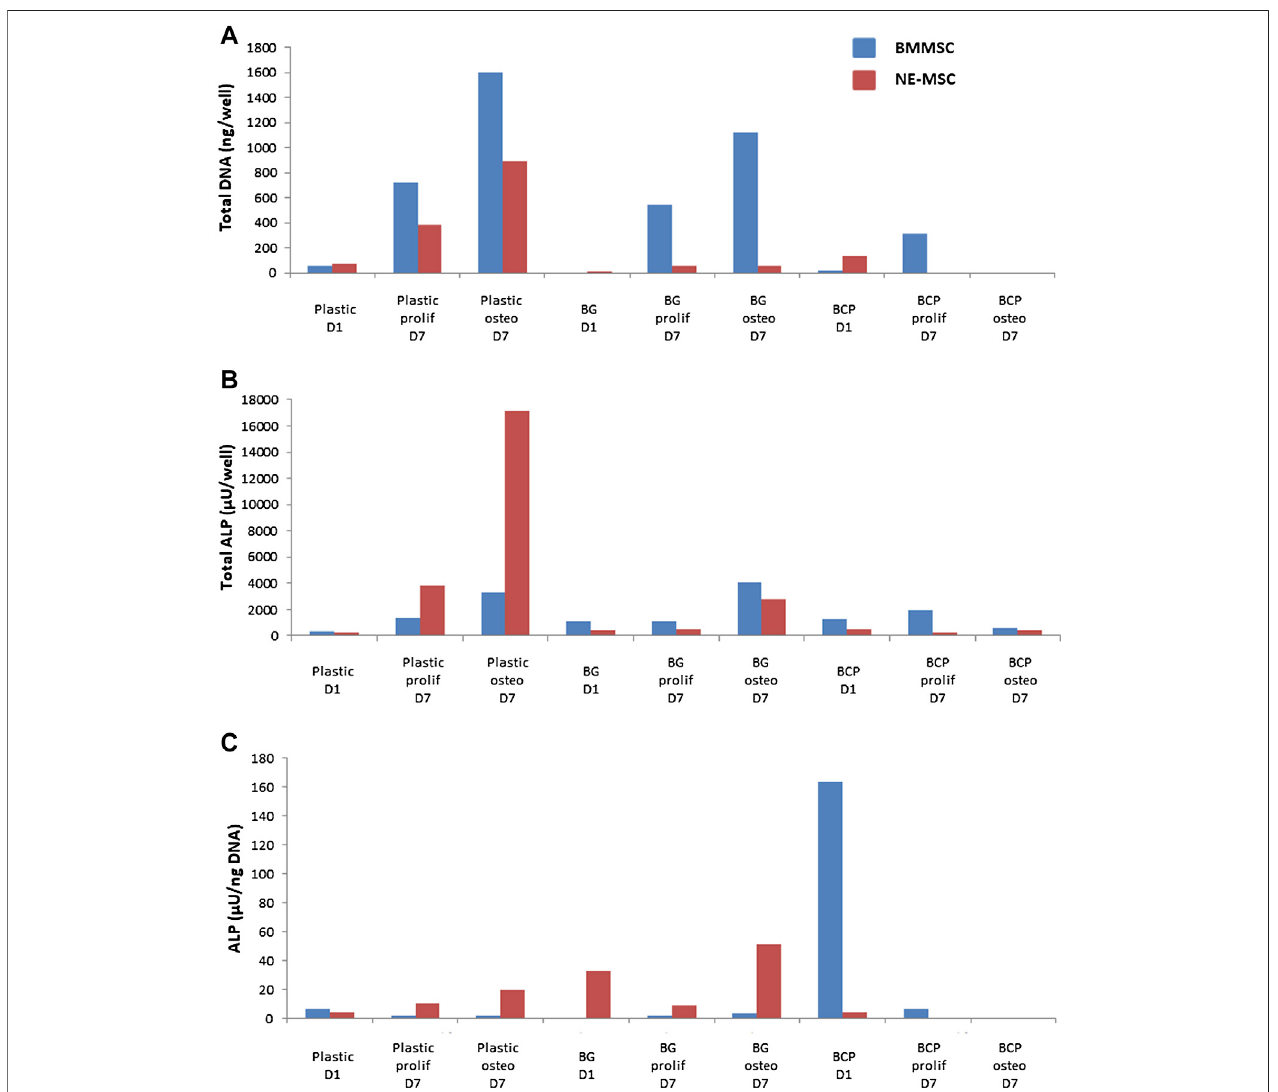
FIGURE6| Quanti fi cationofalkalinephosphatase(ALP).Forthepurposeofcomparison,thetotalamountofDNA,atD1andD7,wasquanti fi edforbothcelltypes, BMMSCs and NE-MSCs, in proliferative and osteogenic conditions (A) . The total amount of ALP in each condition was assessed (B) and then compared to the amount of DNA (C) . NE-MSCs express an important amount of ALP when grown on BG, in osteogenic conditions. For BMMSCs, ALP expression is marginal except at D1 on BCP biomaterial.